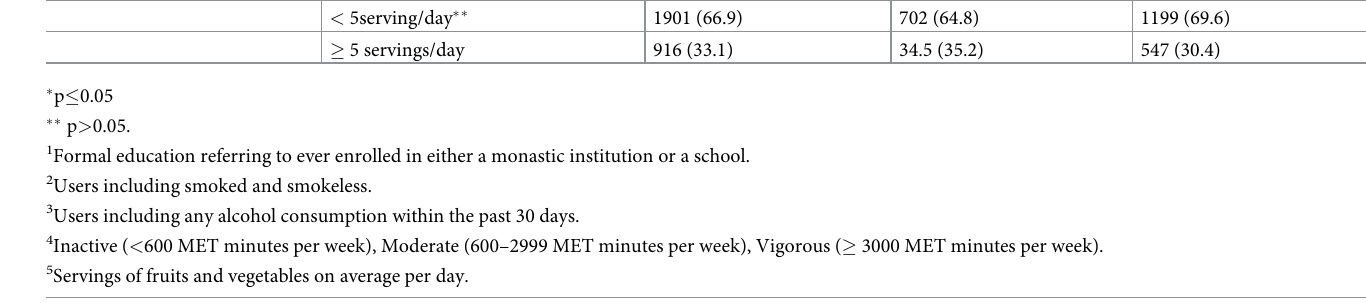
overall prevalence of low physical activity was 6.2% (95% CI: 4.9, 7.8). The prevalence was sig- nificantly higher in women [9.2% (95% CI: 7.0, 12.1)] than men [3.8% (95% CI: 2.7, 5.1) (p < 0.05)]. The prevalence of low physical activity was significantly higher (p < 0.05) in urban areas [12.9% (95% CI: 9.2, 17.7)] than the rural areas [3.1% (95% CI: 2.3, 4.2)]. Overall, 66.9%